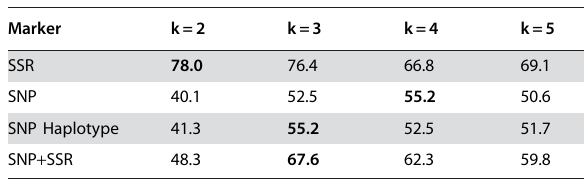
Table 2. Number of haplotypes observed in multi-SNP